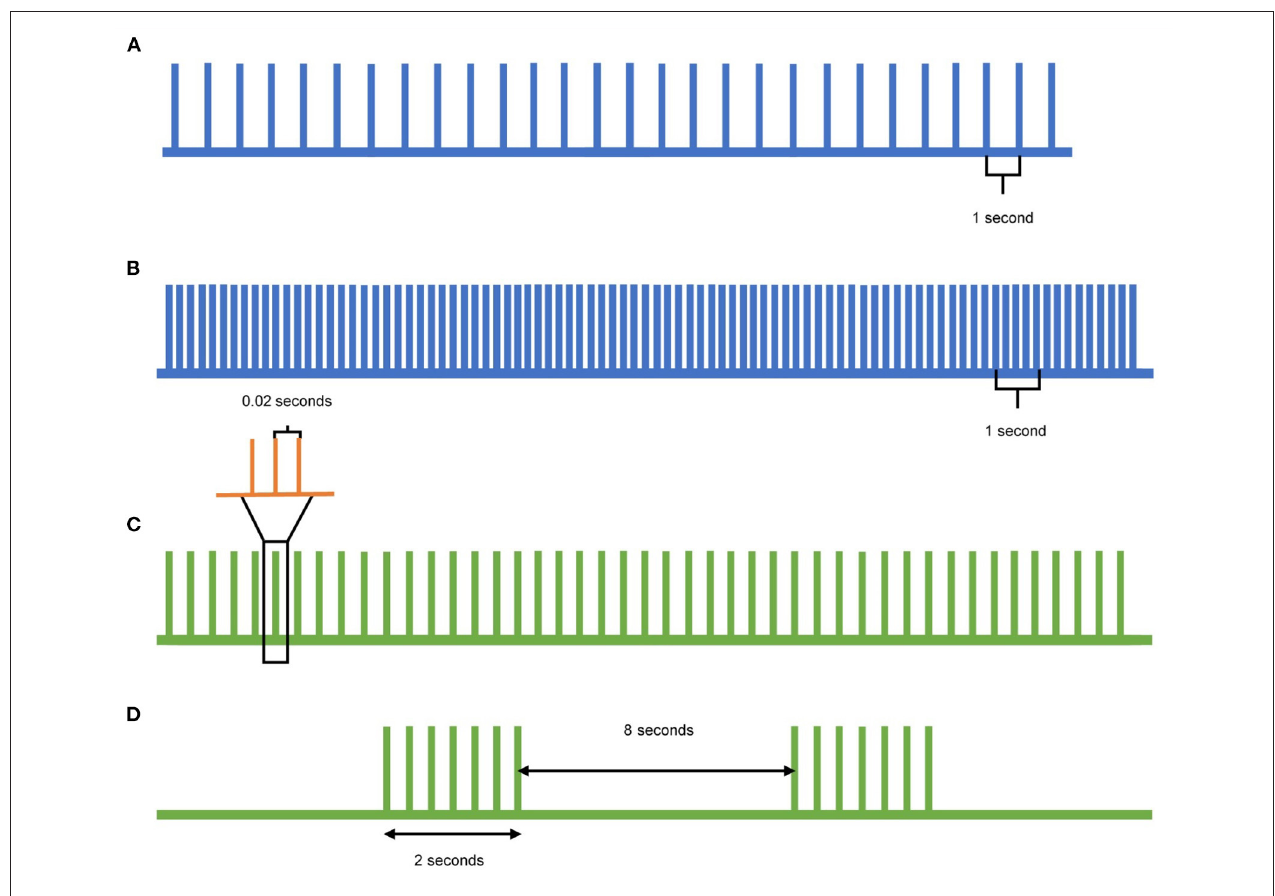
FIGURE 2 | Pulse patterns of different rTMS protocols. (A) Low-frequency TMS is delivered at a rate of 1Hz or lower and acts as inhibitory stimulation. (B) High-frequency TMS is delivered at a rate of 5Hz or higher and acts as excitatory stimulation. (C) Continuous theta-burst stimulation (cTBS) delivers a triplet burst of pulses continuously, and acts as inhibitory stimulation. Each green pulse represents three pulses given at 50Hz (orange), whereas each green pulse is delivered at 5Hz. (D) Intermittent theta-burst stimulation (iTBS) delivers a triplet burst of pulses intermittently, acting as excitatory stimulation. Each triplet burst (green) is delivered at 5Hz over 2s with an 8s pause